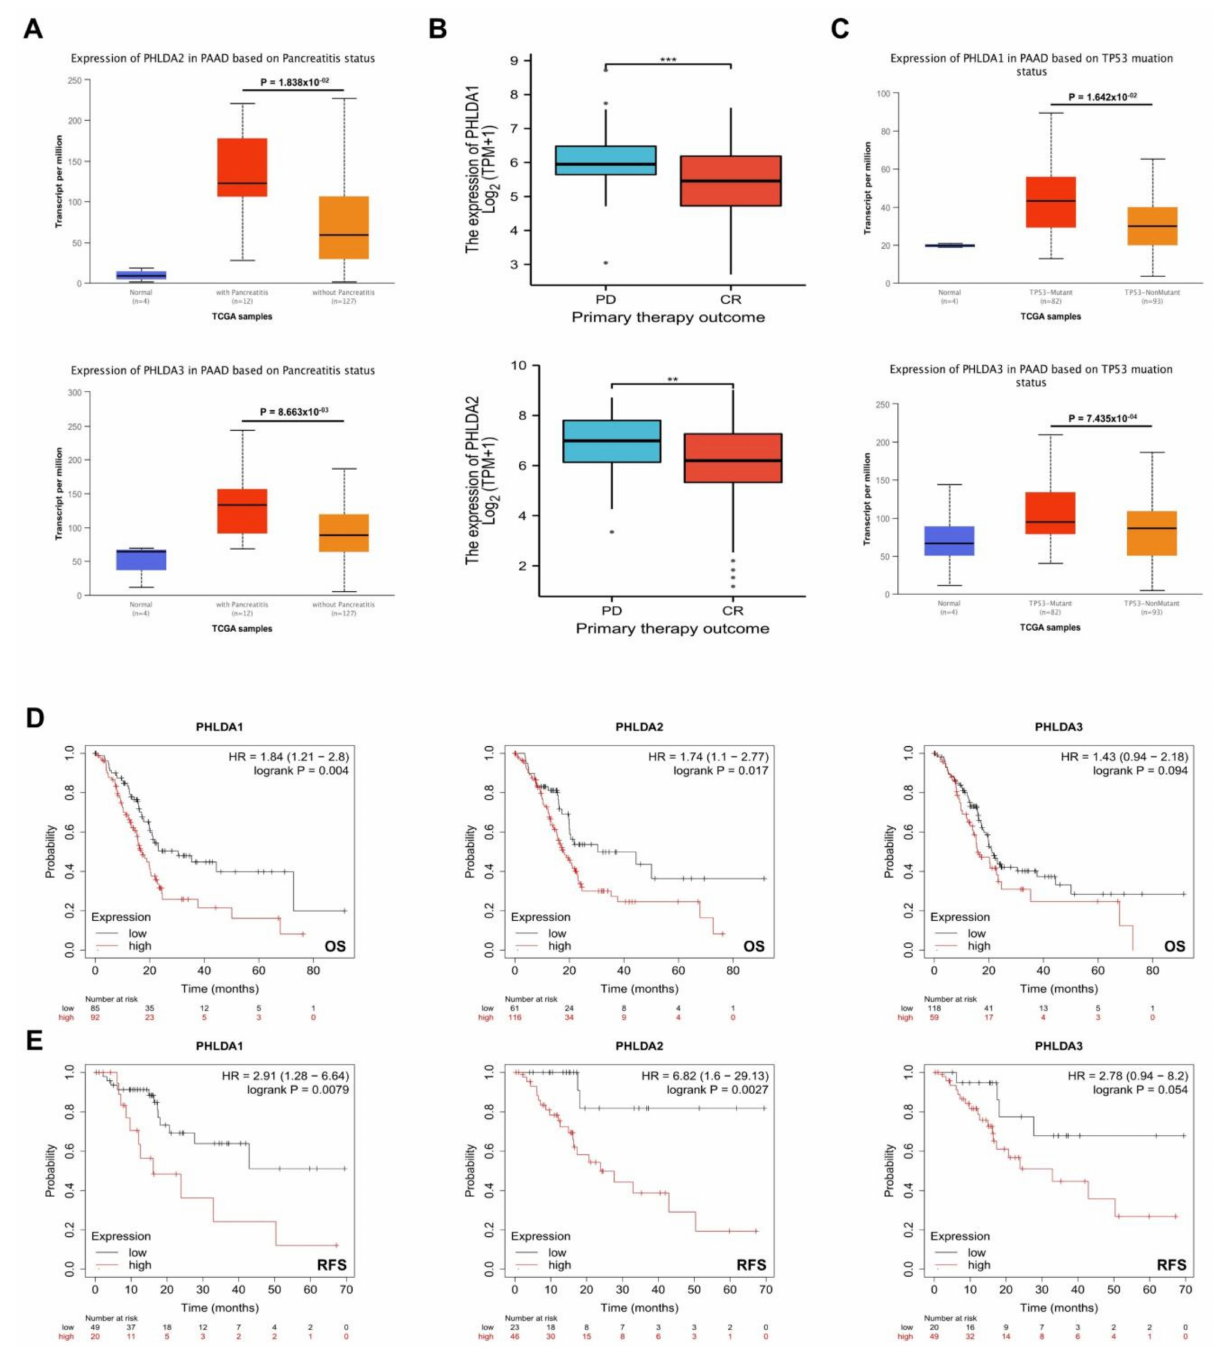
Figure 2. The relationship between expression levels of PHLDA family members and clinicopatho- logic features, TP53 mutation status, and prognosis of PAAD patients. ( A ) High expression of PHLDA2/3 was significantly correlated with a previous history of pancreatitis; ( B ) high expression of PHLDA1/2 was significantly correlated with a worse initial treatment effect; ( C ) the expression levels of PHLDA1/3 in the TP53 mutant PAAD tissues were significantly higher than those in the TP53 wild − type PAAD tissues; ( D , E ) the increased expression levels of PHLDA1 and PHLDA2 were significantly correlated with shorter OS and RFS. ** p < 0.01; *** p <